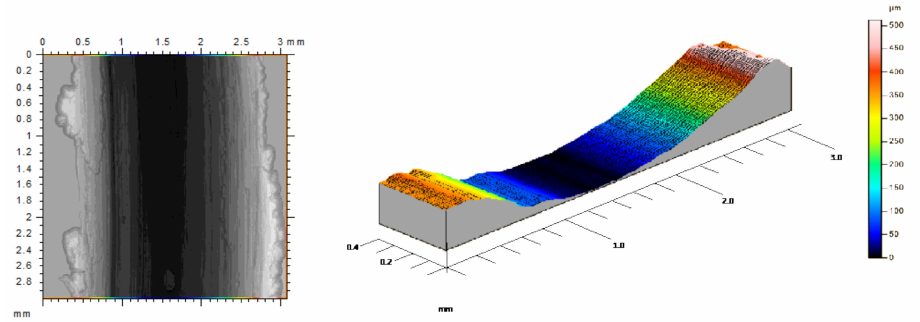
Figure 5. Second stage sliding track with abrasive wear